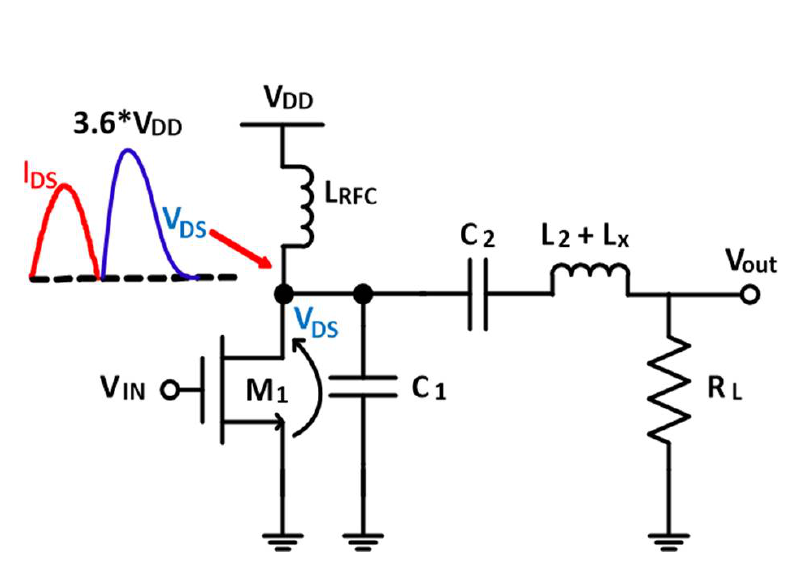
Figure 1. ConventionalClass-E power amplifier (PA) using NMOS transistor with radio frequency RF-choke and series LC